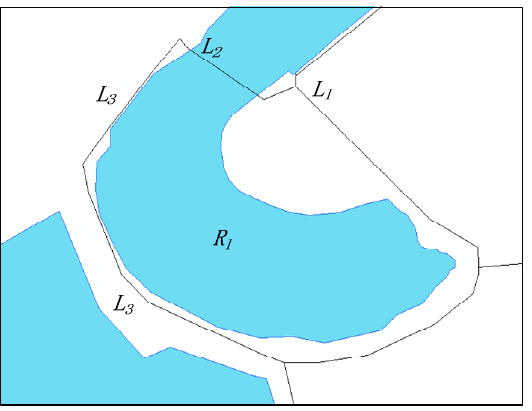
Figure 19. Examples of topological conflict addressing results between lines/regions.